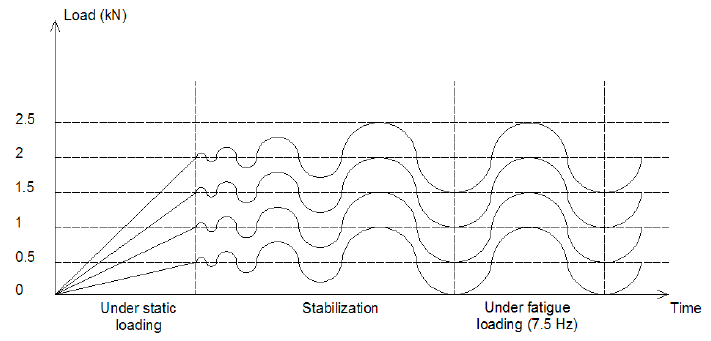
Figure 6. Test protocol for fatigue cycles with different amplitudes.